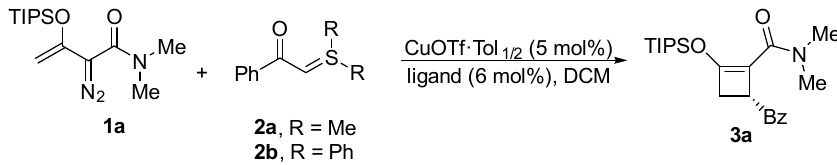
Figure 2. [3 + 1]-cycloaddition reactions with enoldiazoamide 1a .